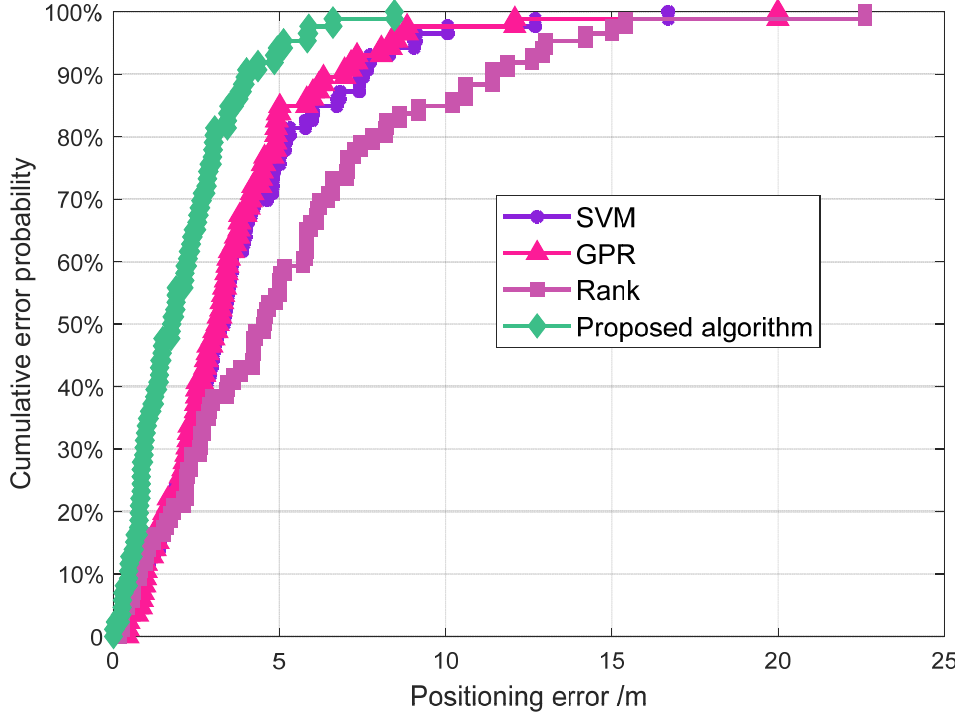
Figure 13. CDFs of SVM, GPR, rank, and the proposed method.